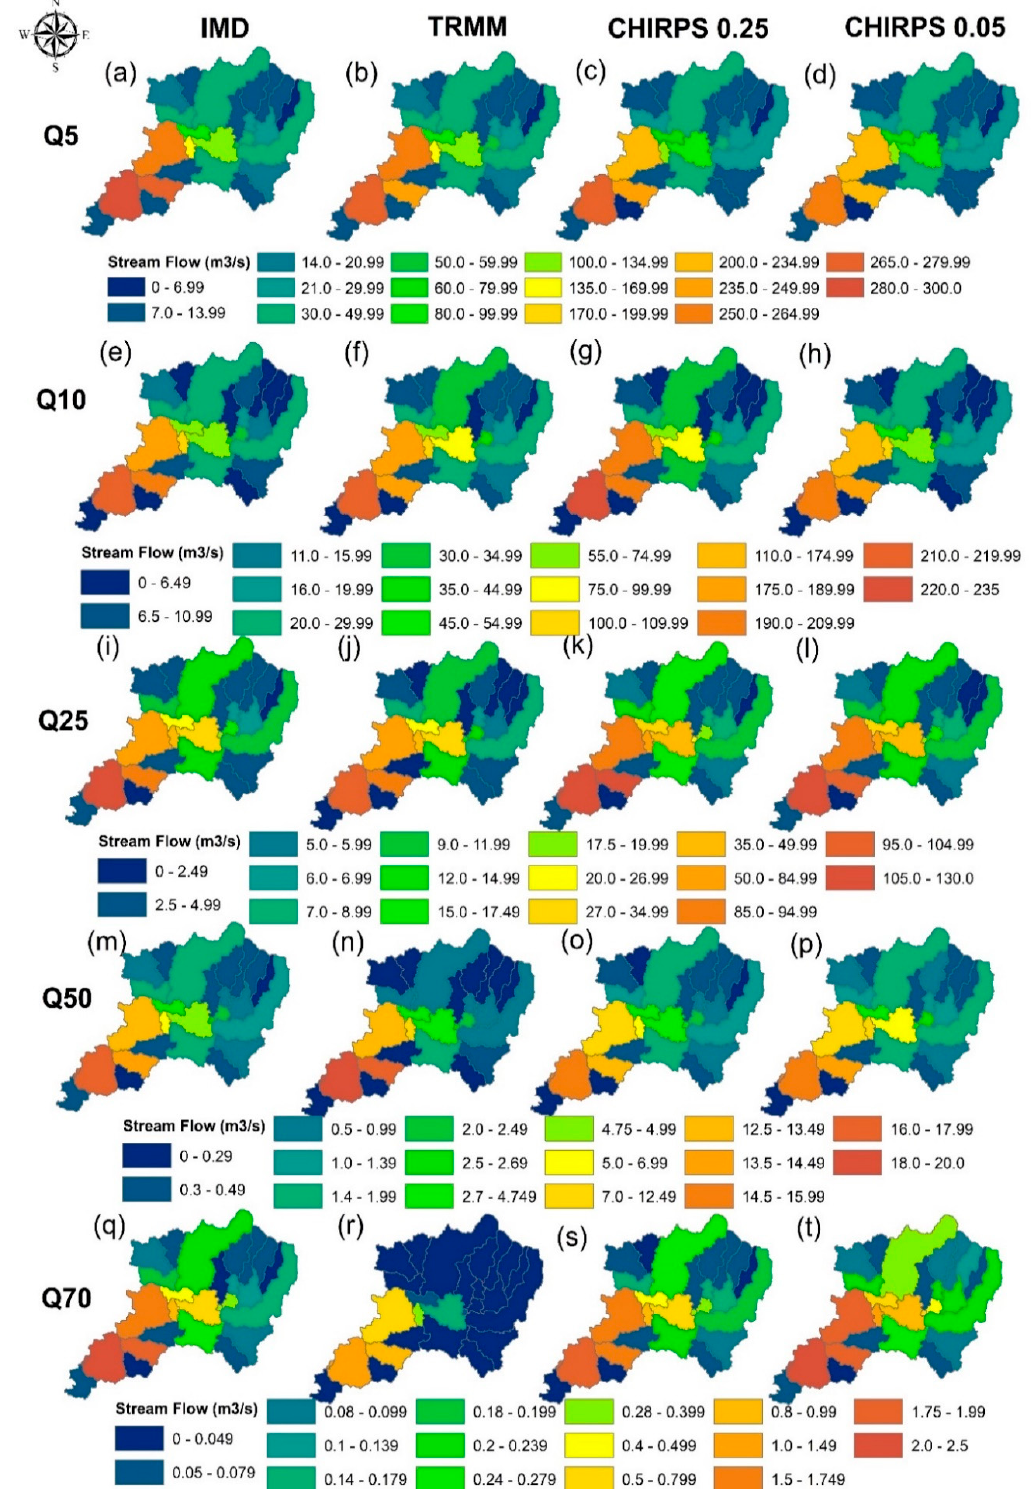
Figure 7. Spatial distribution of the dependable flow of ( a ) IMD-Q5, ( b ) TRMM-Q5, ( c ) CHIRPS 0.25-Q5, ( d ) CHIRPS 0.05-Q5, ( e ) IMD-Q10, ( f ) TRMM-Q10, ( g ) CHIRPS 0.25-Q10, ( h ) CHIRPS 0.05-Q10, ( i ) IMD-Q25, ( j ) TRMM-Q25, ( k ) CHIRPS 0.25-Q25, ( l ) CHIRPS 0.05-Q25, ( m ) IMD-Q50, ( n ) TRMM-Q50, ( o ) CHIRPS 0.25-Q50, ( p ) CHIRPS 0.05-Q50, ( q ) IMD-Q70, ( r ) TRMM-Q70, ( s ) CHIRPS 0.25-Q70, ( t ) CHIRPS 0.05-Q70, rainfall datasets for the Gurupura catchment.